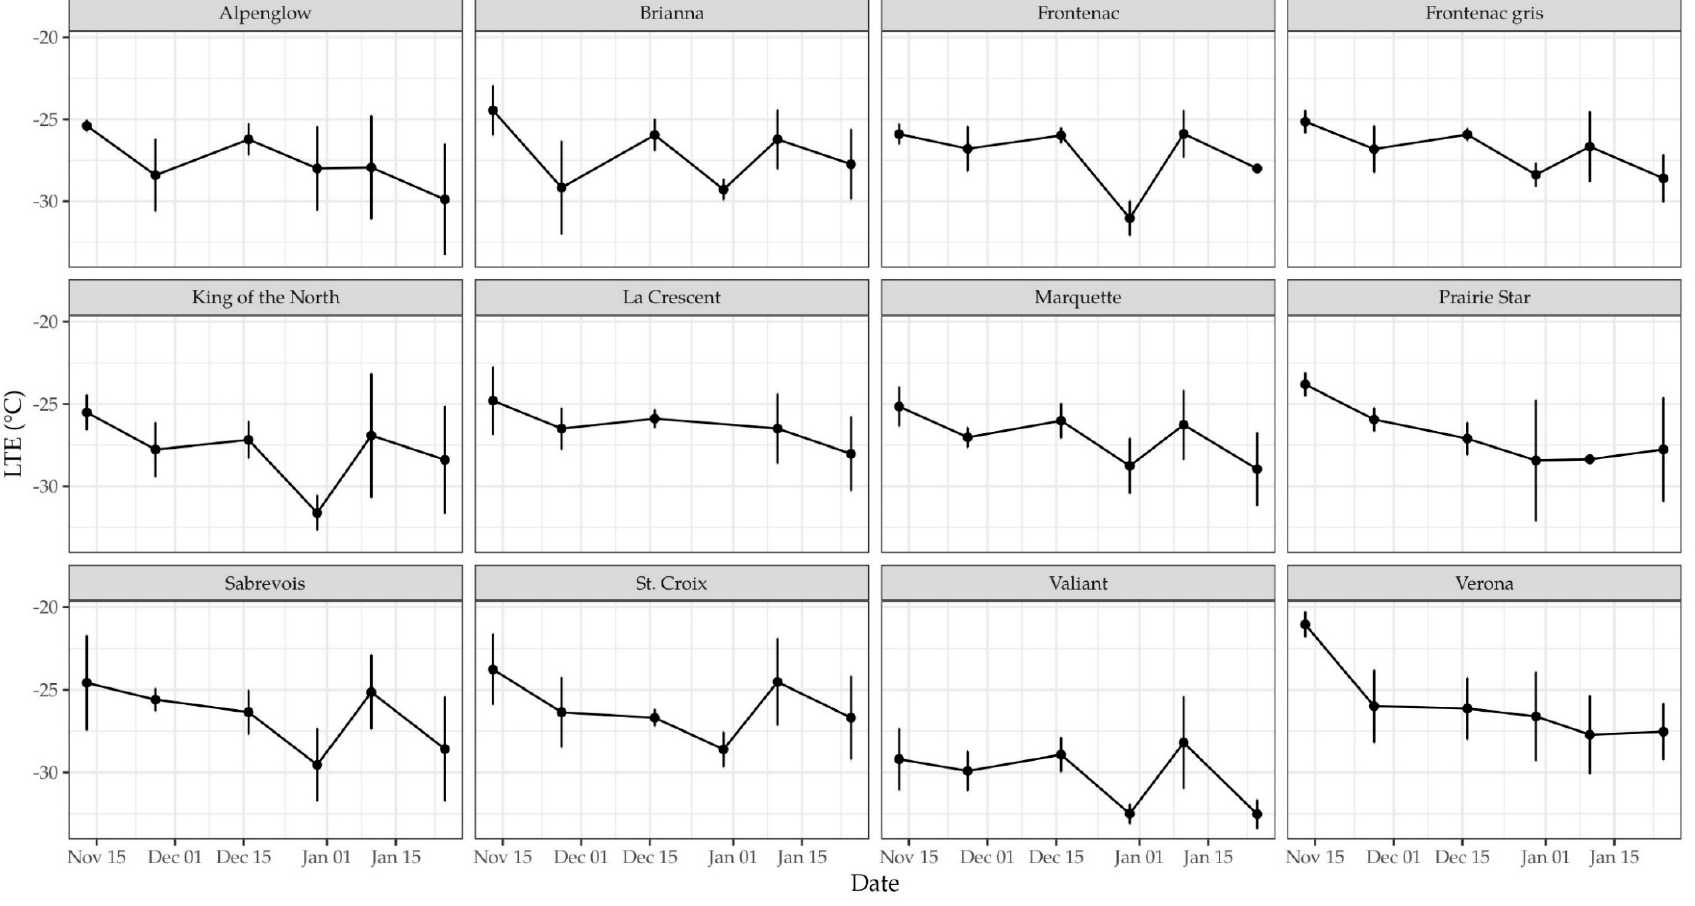
Figure 4. Mean LTE 50 values (± standard deviation) for 12 cultivars sampled during 2018–2019 winter in the grape variety trial located at the NDSU Horticulture Research Farm near Absaraka, ND, USA.